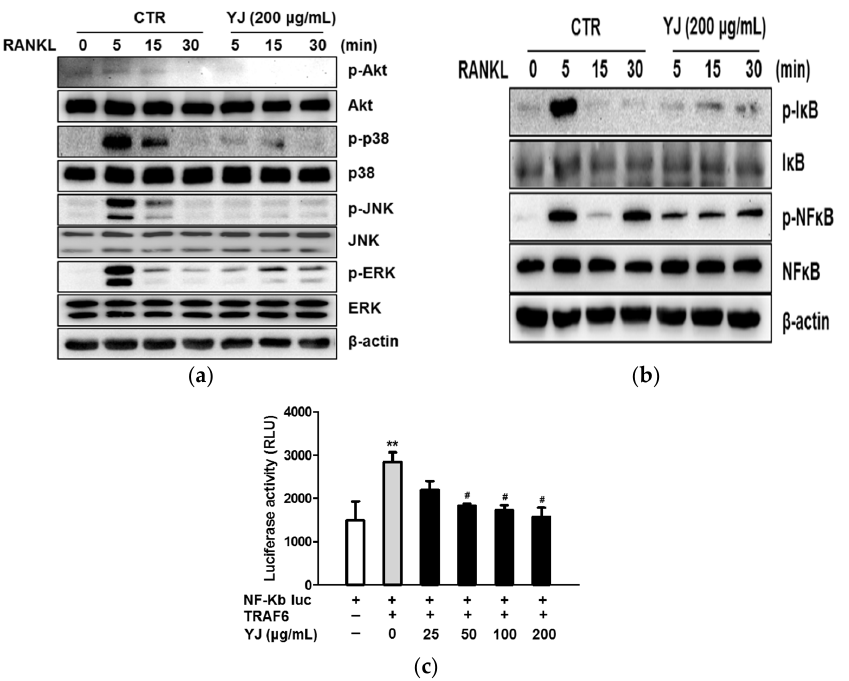
Figure 4. YJ suppresses RANKL-mediated early signaling in osteoclast differentiation. ( a , b ) BMMs were serum-starved for 2 h and pre-treated with YJ (200 μ g/mL) for 1 h and then treated with RANKL (100 ng/mL) for the indicated time. The cell lysates were evaluated by Western blotting. ( c ) 293T cells were co-transfected with TRAF6 and NF- κ B-luciferase reporter plasmid. Luciferase activity was assayed using a luciferase assay system. The data presented are the mean ± SD of three independent experiments. ** p < 0.01 vs. the control group and # p < 0.01 vs. the TRAF6-stimulated group.